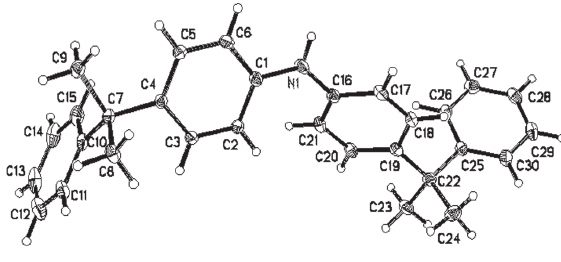
Table 1: Data collection and handling.